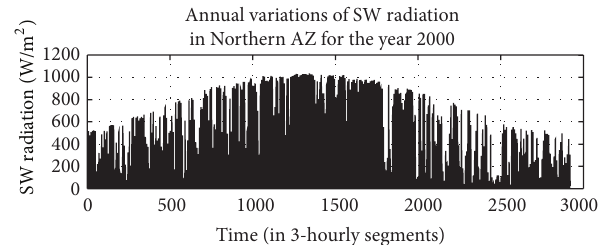
Figure 5: The time series of three-hourly downward shortwave radiation at surface, averaged over multiple grid points that cover Northern Arizona, for the year 2000 from the GFDL CM2.0 20th century simulation. The unit on the ordinate is W/m 2